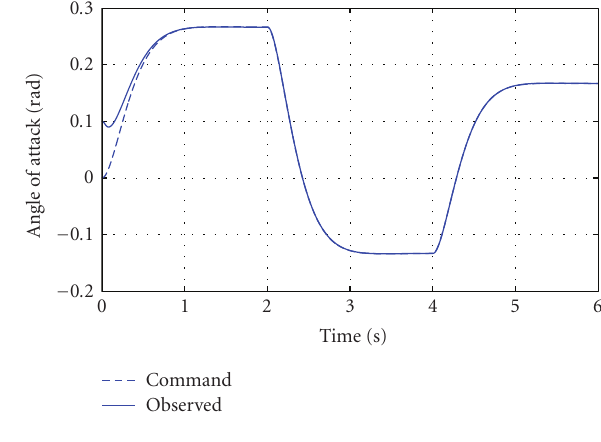
Figure 10: Output tracking with observer.